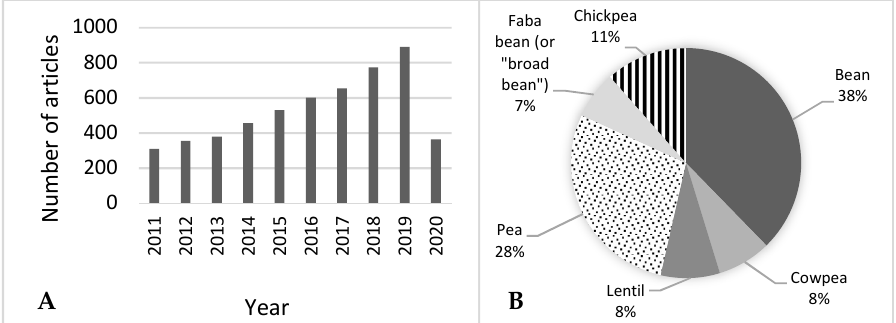
Figure 1. Number of articles regarding the extrusion cooking of legumes published from January 2011 to April 2020 ( A ) and percent distribution of articles according to legume type ( B ). (Elaboration of data from the Scopus database).